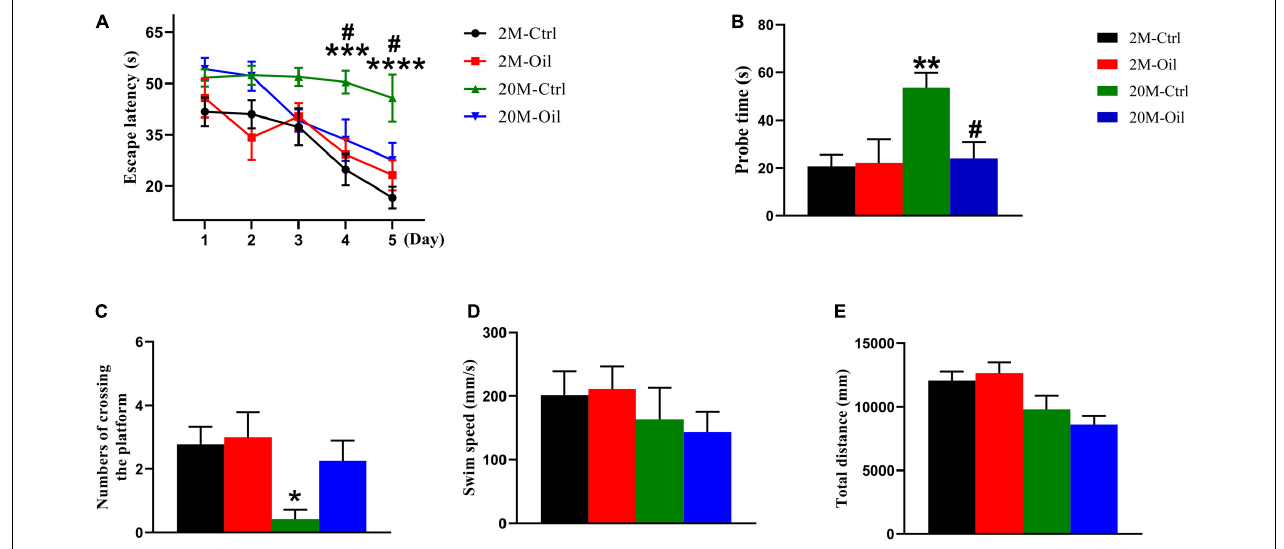
FIGURE 1 | Acer truncatum seed oil ameliorated cognitive deficits of aging mice. (A) Oil treatment improved learning ability of aging mice shown by decreased escape latency during training phase detected by Morris water maze. Two-way repeated measures ANOVA tests followed by Tukey’s multiple comparison tests, *** p < 0.001, **** p < 0.0001 (2M vs. 20M); # p < 0.05 (20M vs. 20M-Oil). (B) Oil treatment improved the memory capacity shown by the decreased escape latency of aging mice during the test. One-way ANOVA followed by Tukey’s multiple comparison tests, ** p < 0.01 (2M vs. 20M); # p < 0.05 (20M vs. 20M-Oil). (C) The number of times that aging mice crossed the platform was significantly decreased than that of young mice. One-way ANOVA followed by Tukey’s multiple comparison tests, * p < 0.05 (2M vs. 20M). There was no significant difference in swimming speed (D) or total swimming distance (E) among the 4 groups. One-way ANOVA followed by Tukey’s multiple comparison tests. All data were expressed as mean ± SEM, n = 7–9 mice for each